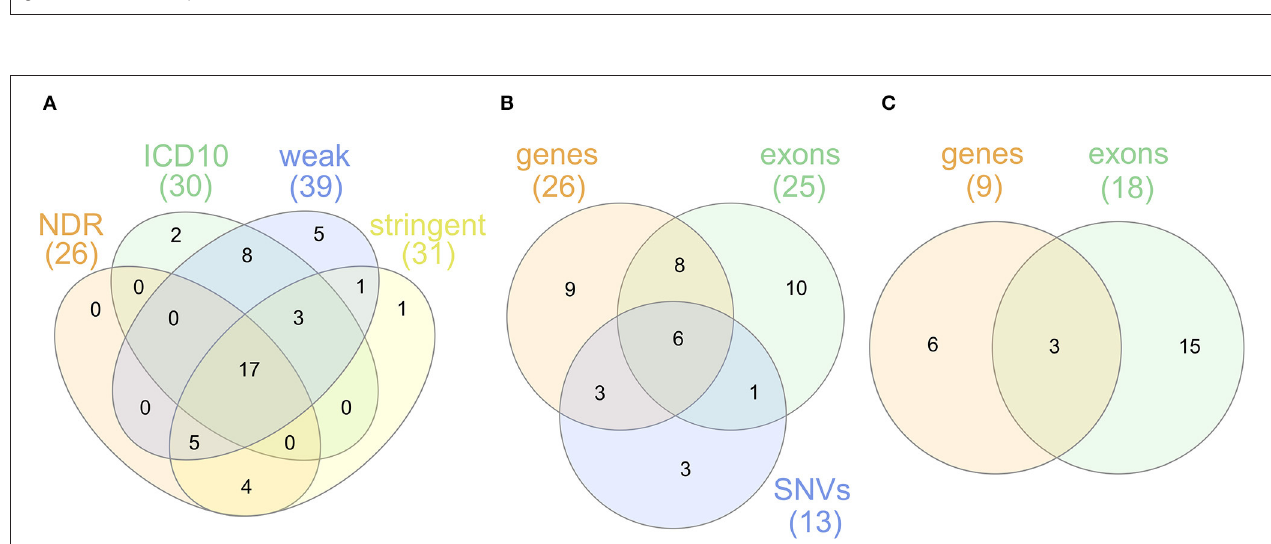
FIGURE 2 | (A) Venn diagram for genes found to be significantly associated with the T1D definitions NDR, ICD10, weak and stringent using the linear SKAT model. (B) Venn diagram for genes found to be significantly associated with NDR-defined T1D in the single-SNV analysis and the gene- or exon-based test using the linear